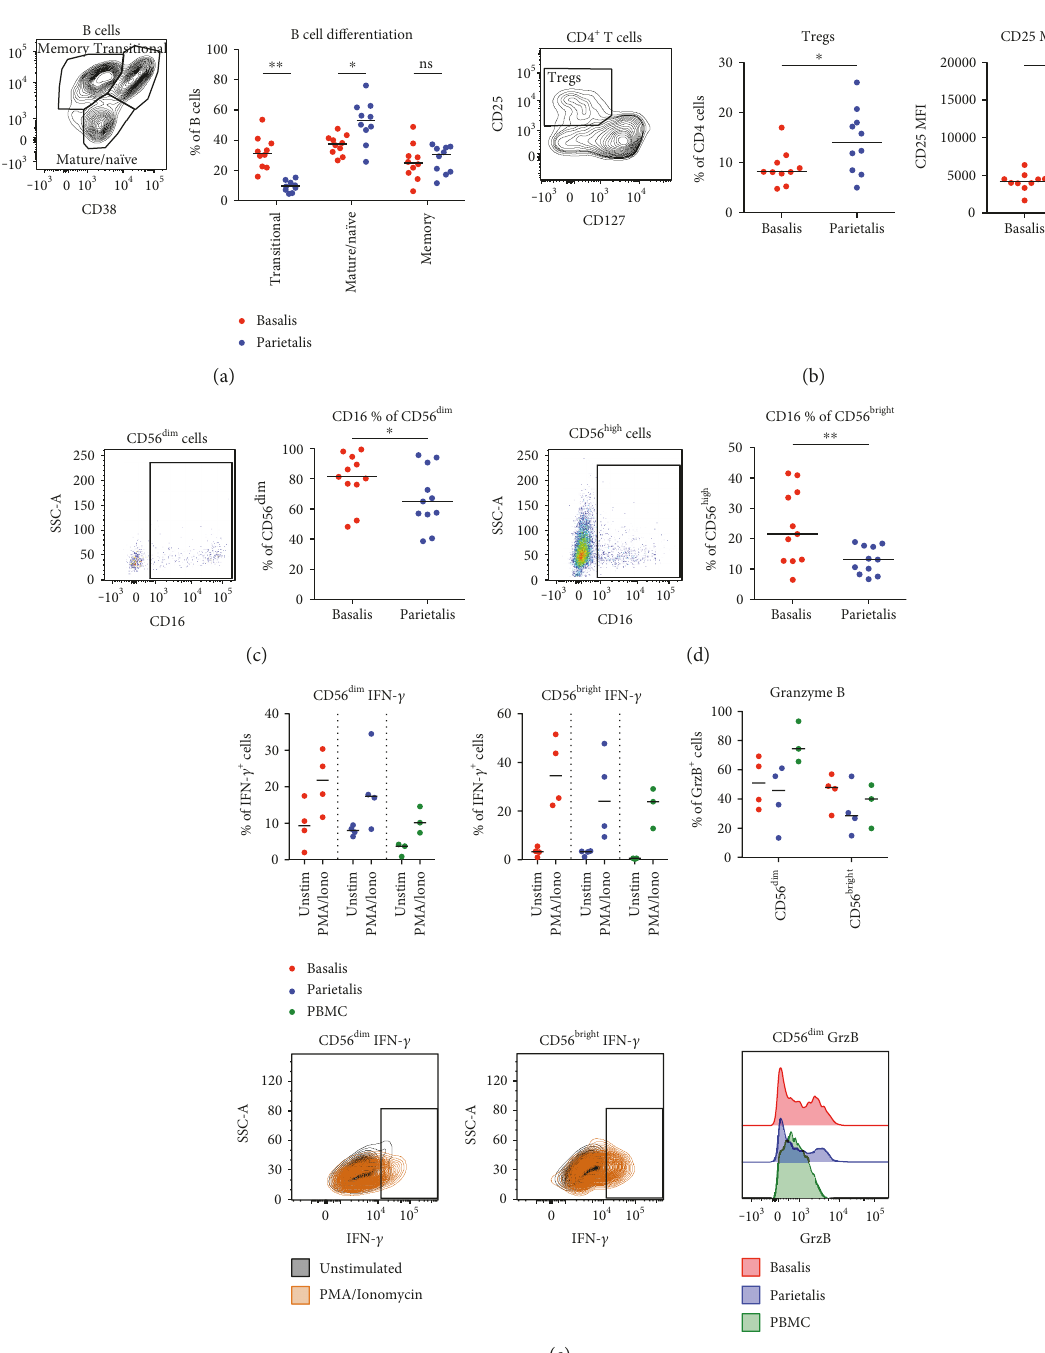
Figure 5: Maturational state of B cells and frequencies of T regulatory cell di ff er between decidual compartment. (a) Gating strategy (left) and graphical representation (right) of di ff erentiation status of B cells from paired samples of decidua basalis and parietalis ( n = 10 ). (b) Gating strategy and proportions of T regulatory cells (Tregs) as percentage of CD4 + T cells (middle) and the median fl uorescence intensity (MFI) of CD25 of the gated Tregs (right) ( n = 10 ). (c) Gating strategy (left) and graphical representation (right) of CD16 expression on CD56 dim cells from paired samples of decidua basalis and parietalis ( n = 11 ). (d) Same as in (c) but for CD56 high cells ( n = 11 ). (e) Paired mononuclear cells from basalis ( n = 4 ) and parietalis ( n = 4 ) were stimulated for 5 hours with PMA/ionomycin or left unstimulated. Data on cells from healthy controls (PBMC) were included as controls ( n = 3 ). Intracellular expression of interferon- γ (IFN- γ ) and granzyme B (GrzB) was determined by fl ow cytometry. T cells were divided into CD56 dim (upper left) and CD56 bright (upper middle), representative contour plots below the respective cell subset. GrzB was measured in unstimulated samples only (upper right), representative histograms shown in the bottom right corner. Line in graphs depicts the median. Comparisons between the paired samples were made using the nonparametric Wilcoxon test. ns=not signi fi cant; ∗ p < 0 05 ; ∗∗ p < 0 01